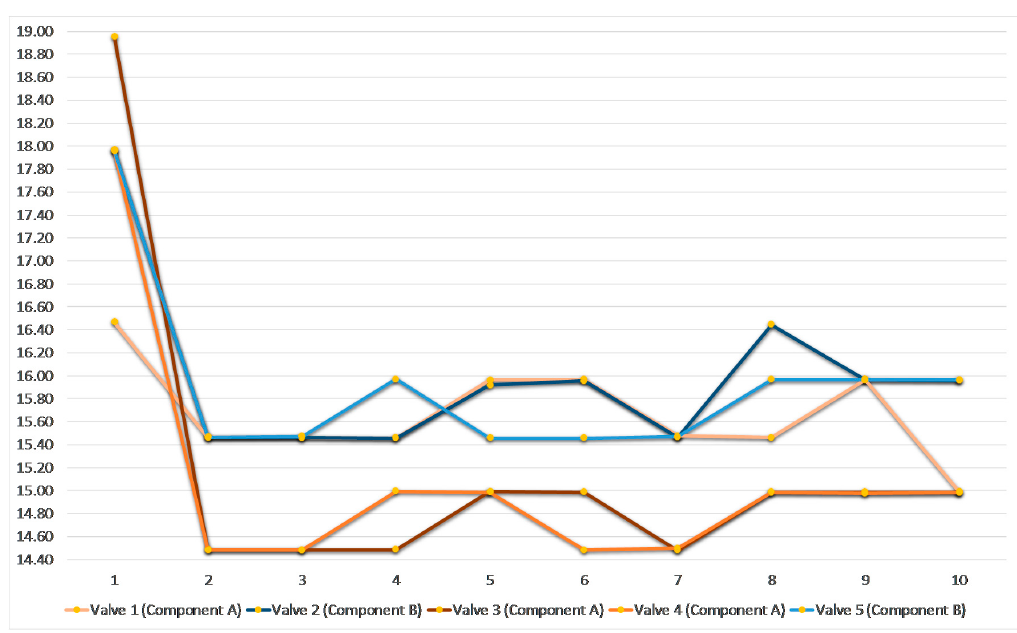
Figure 9. Results of a Valve Sync. test run (initial experiment) [4].